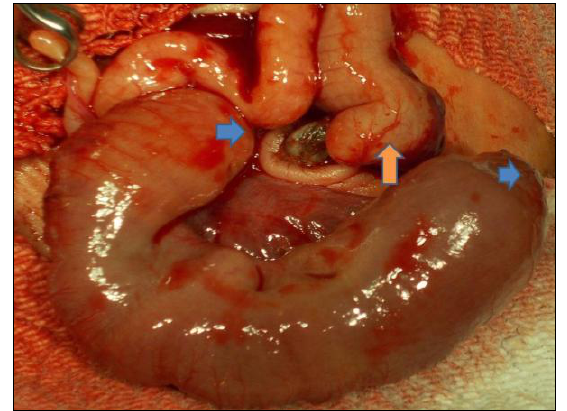
Figure 1: Multiple small bowel (blue arrow) atresias and a large bowel (salmon arrow)